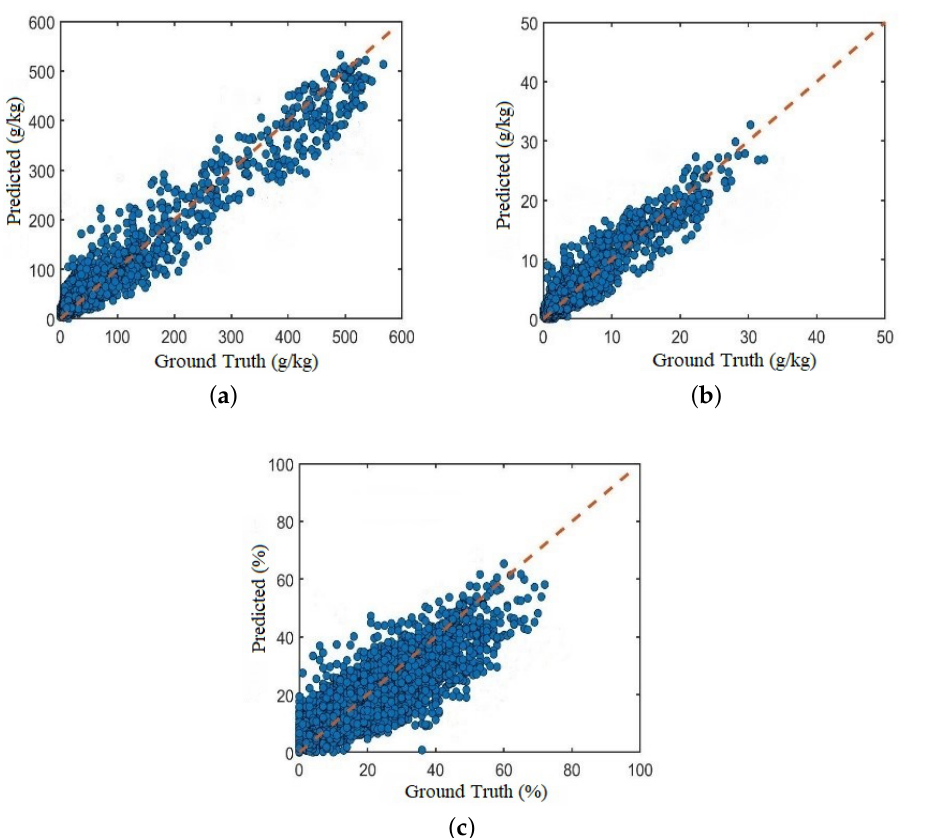
Figure 10. Actual vs Predicted values of Multi_CNN model ( a ) Organic Carbon ( b ) Nitrogen ( c )